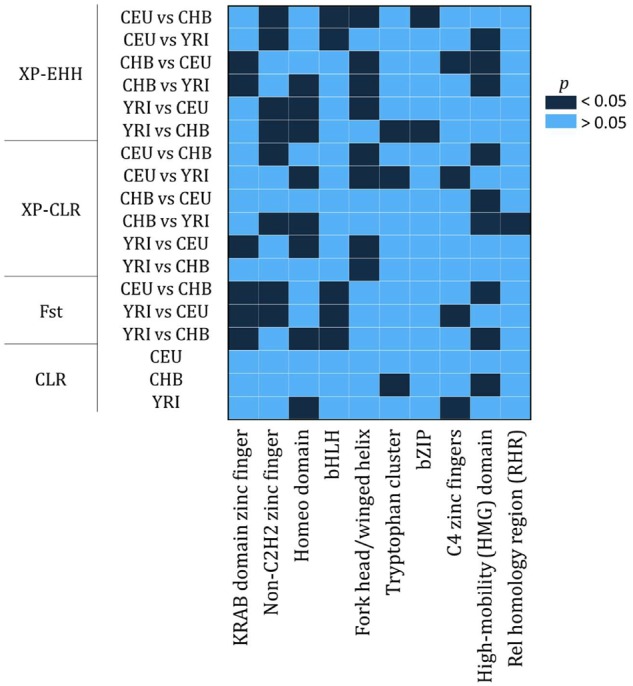
—Enrichment analyses for genes from the ten largest DNA–binding GRFs classes located in regions exhibiting high scores for four methods for detecting candidate regions for positive selection and one for measuring genetic differentiation. This heatmap shows the results from the Fisher’s exact test after correcting for multiple testing by using the Bonferroni correction for each population or cross-population comparison, respectively.